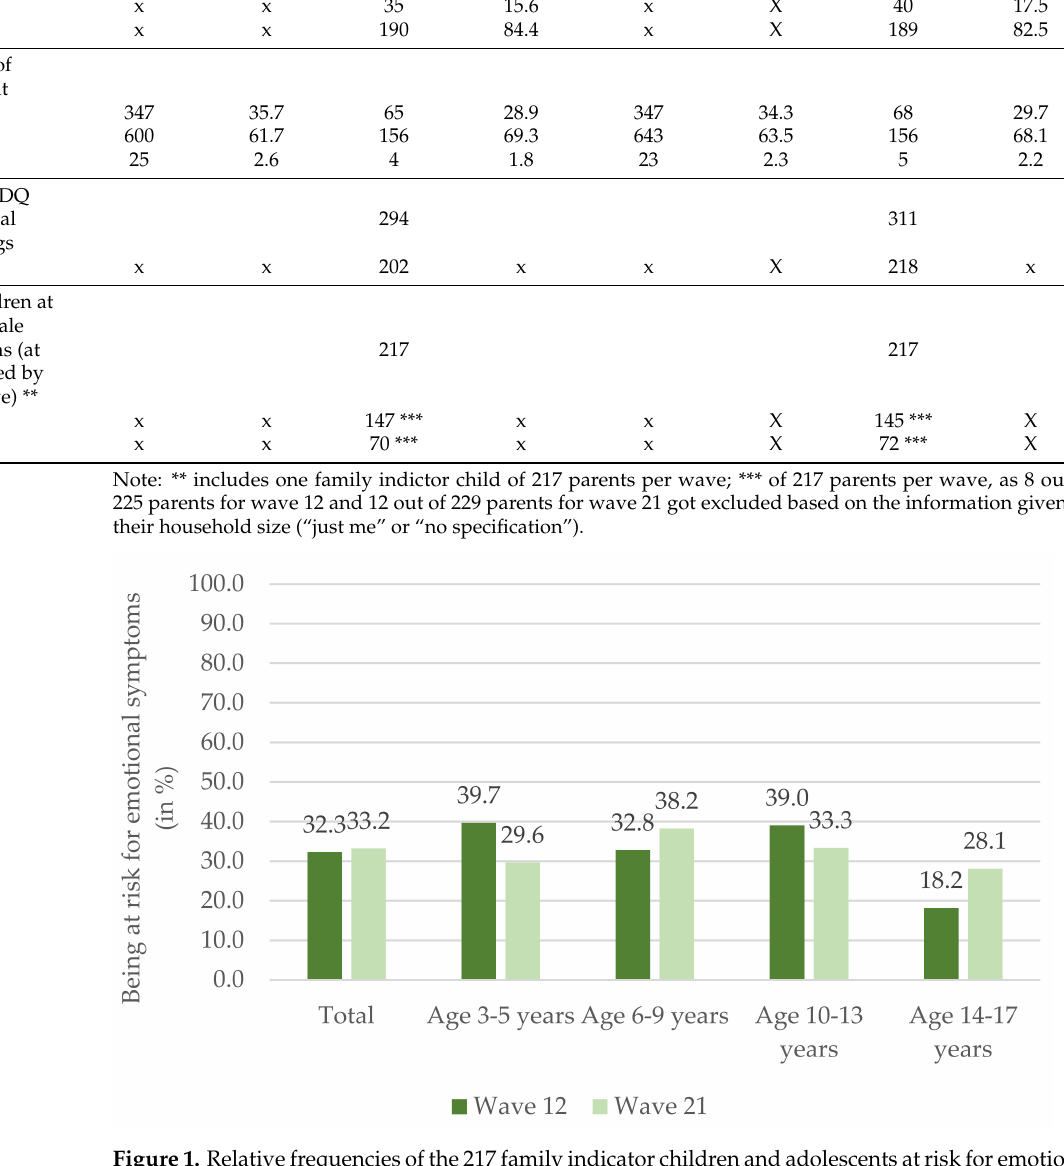
Figure 1. Relative frequencies of the 217 family indicator children and adolescents at risk for emotional symptoms based on the SDQ subscale in waves 12 and 21,